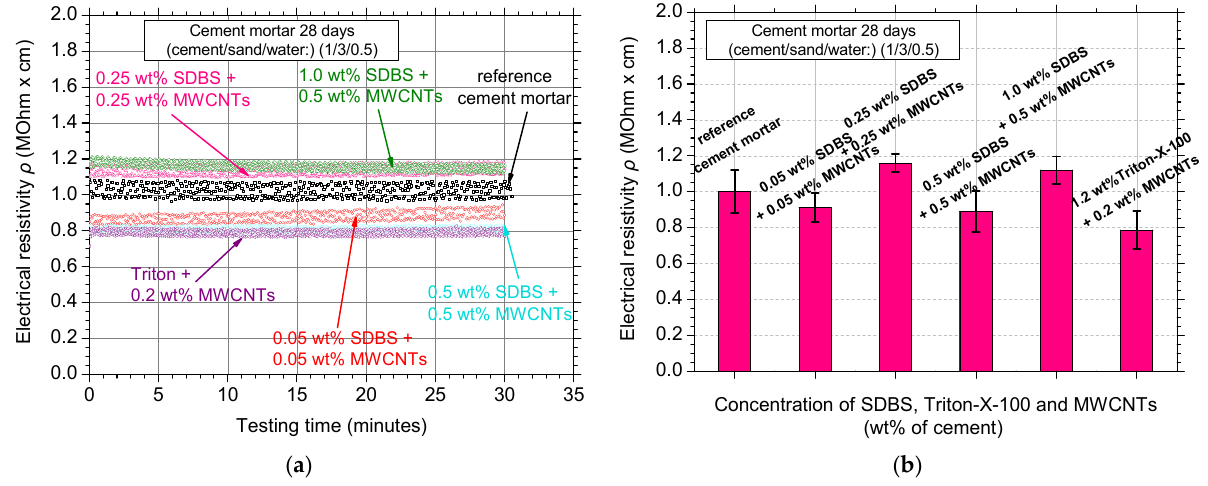
Figure 4. ( a ) Electrical resistivity curves over testing time and ( b ) average electrical resistivity values of the nanocomposites dispersed with the SDBS and Triton X-100 surfactants. Typical flexural stress–crack mouth opening displacement curves for the investigated surfactants to disperse the MWCNTs can be seen in Figure 5a. It seems that all investigated cases decreased the flexural strength (peak flexural stress) of the specimens and generally a more brittle behavior was noticed. Particularly for the 0.25 and 1.0 wt% SDBS specimens, all samples were fractured immediately after the initiation of the mechanical testing and therefore their flexural mechanical behavior was not recorded and presented. Similarly, in the case of the Triton X-100 surfactant, large pores were noticed, and the specimens were almost destroyed after demolding (Figure 6). To this end, the lowest flexural strength of less than 1 MPa does not seem to be a surprising result. Concentration of SDBS, Triton-X- 100 and MWCNTs (wt% of cement ) Cement mortar 28 days (cement/sand/water:) (1/3/0.5)